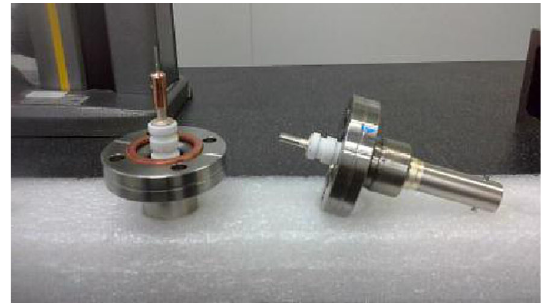
FIG. 15. Photograph of the Kyocera